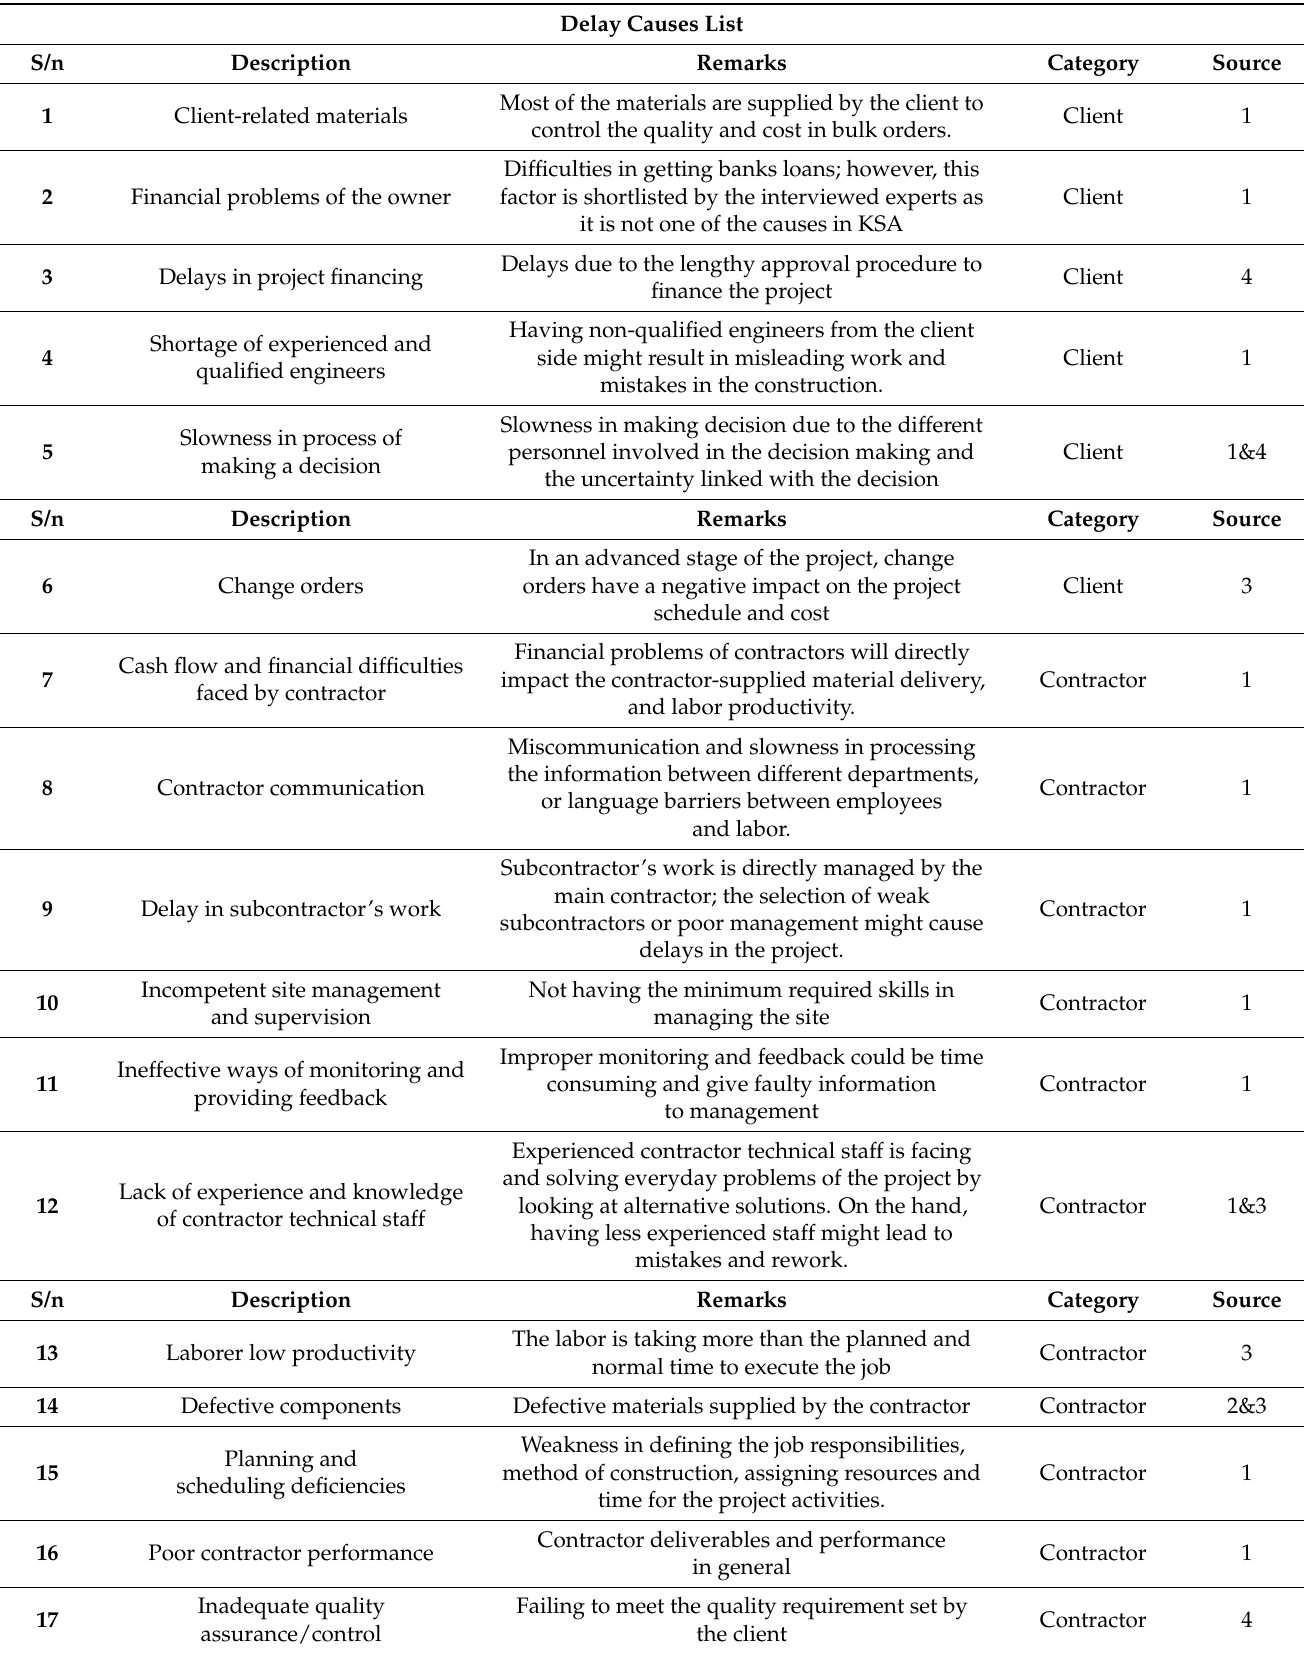
Table 1. Delay Causes